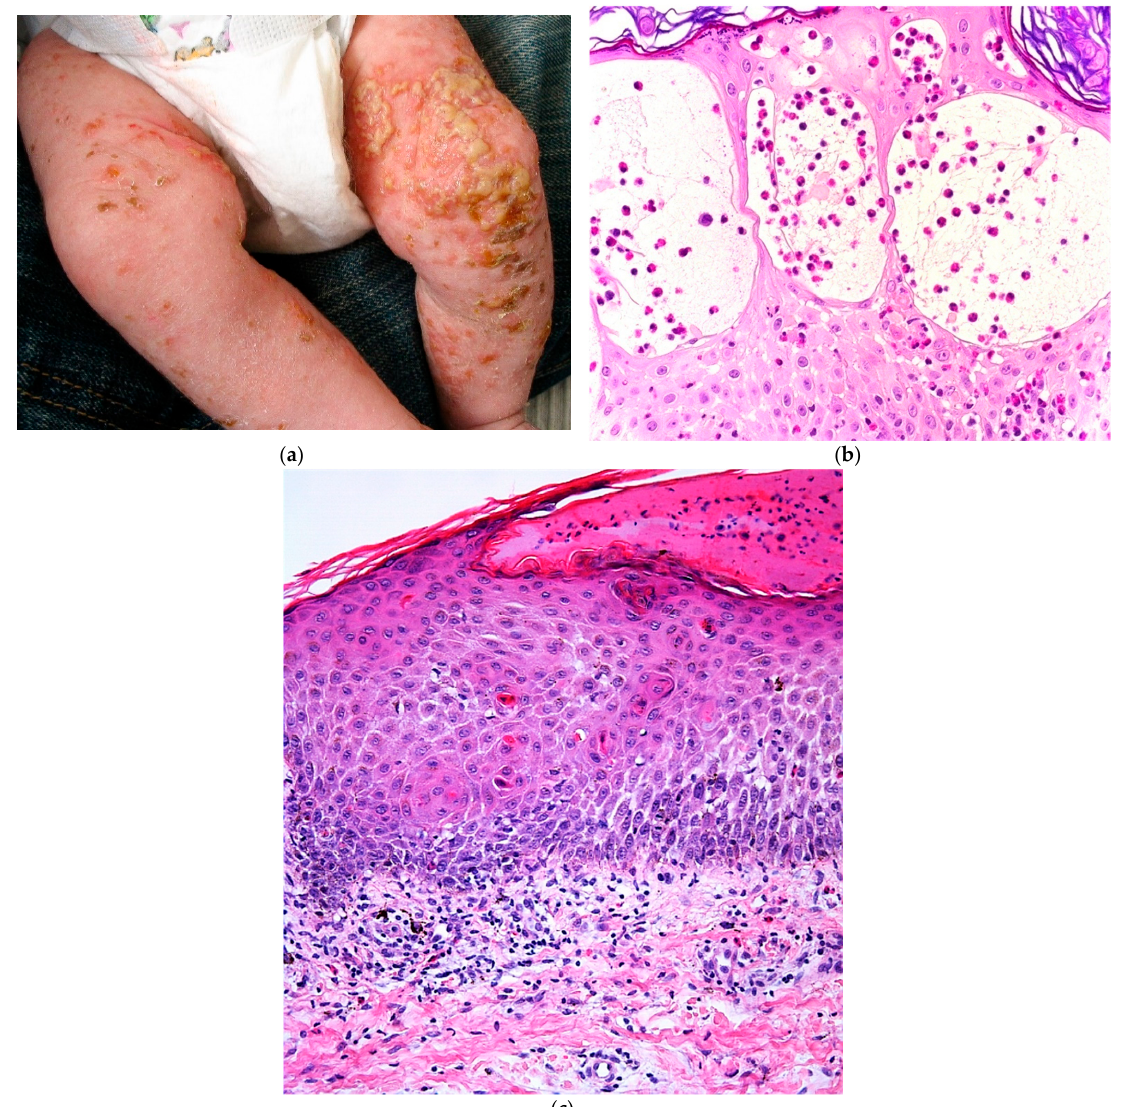
Figure 8. Incontinentia pigmenti. ( a ) Newborn with blistering Blaschko-linear eruption. ( b ) Hematein eosin × 40: spongiosis with eosinophils leading to vesicles. ( c ) Hematein eosin ×20: numerous apoptotic keratinocytes.